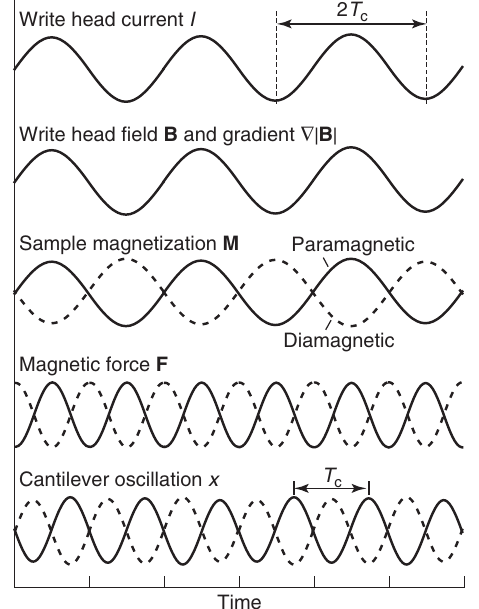
Figure 2 | Basic driving protocol for magnetic susceptibility force microscopy ( v FM). A sinusoidal current with frequency f c /2 is applied to the coil of the write element, generating an oscillating pole magnetic field B and gradient r | B |. The oscillating field in turn induces an oscillating sample magnetization M ¼ w B / m 0 . The sample with volume V experiences a magnetic force F ¼ V r ( M (cid:4) B ) that drives the mechanical resonance f c of an ultrasensitive cantilever force transducer. The amplitude of the resulting cantilever oscillation x is proportional to the force. T c ¼ 1/ f c is one cantilever oscillation period.